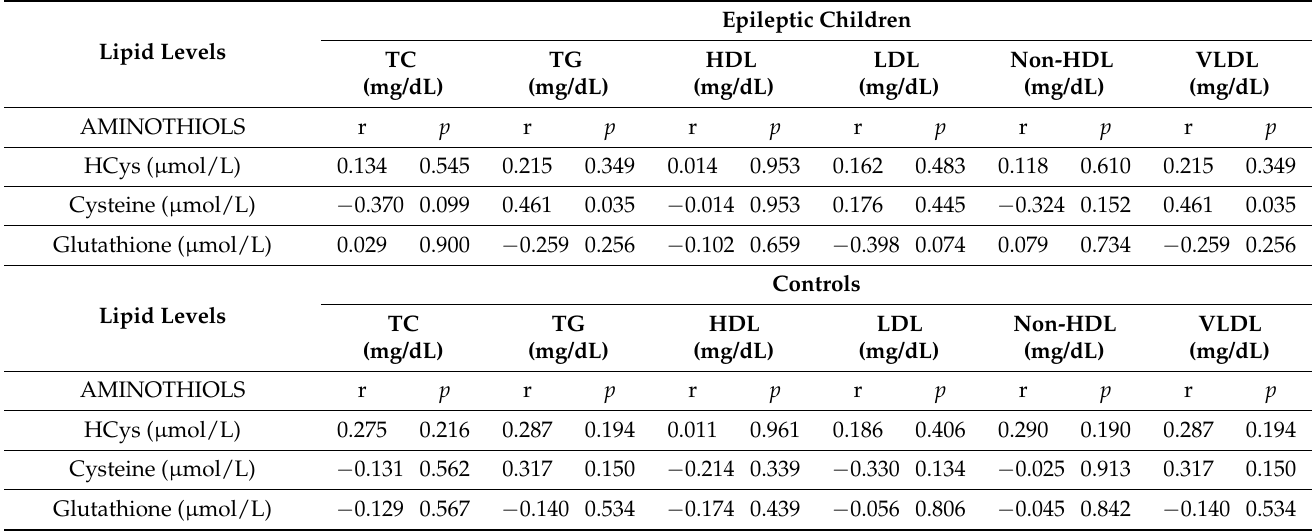
Table 5. Correlation coefficients between the levels of lipids and aminothiols (HCys, cysteine and glutathione) in analyzed